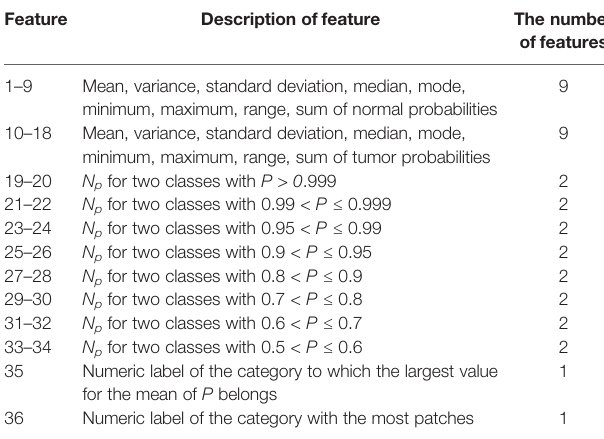
TABLE 2 | The 36 features extracted from a heatmap of malignant probabilities at the WSI-level. Feature Description of feature The number